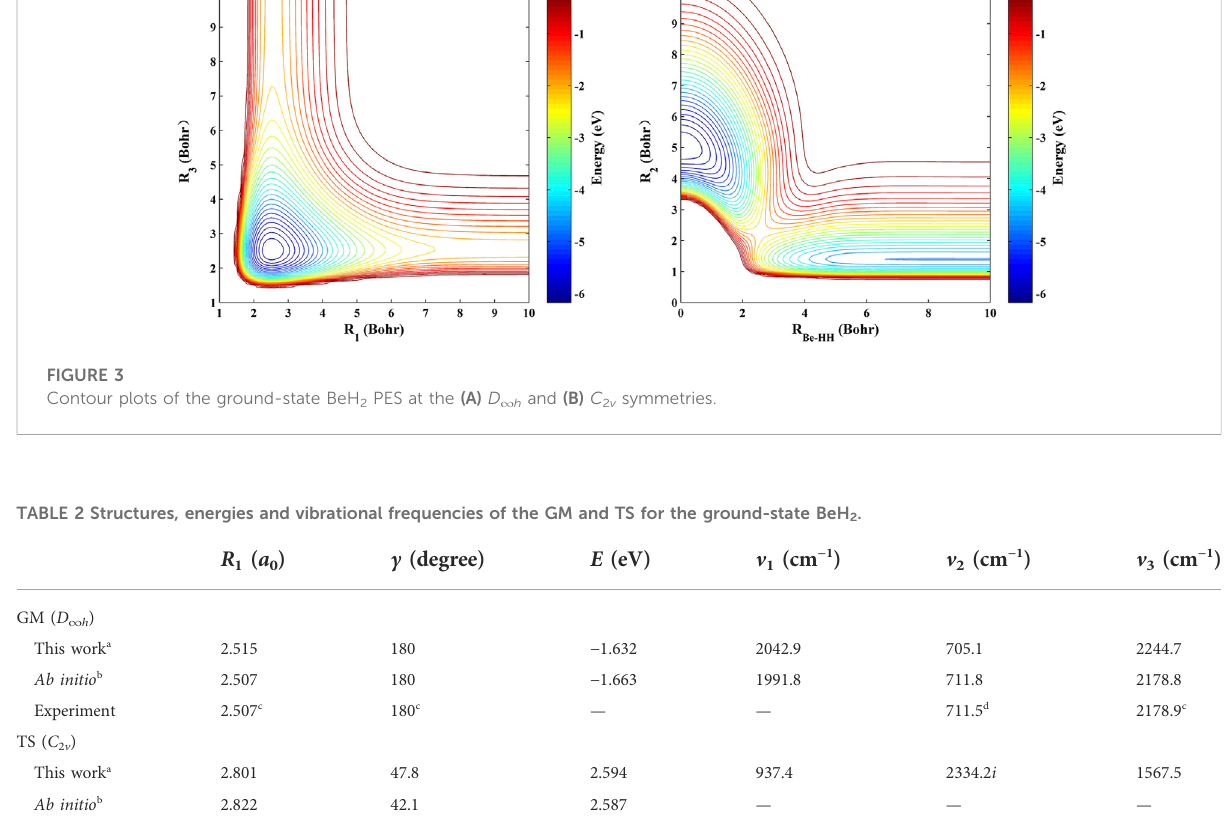
a Obtained on the PIP-NN PES. b Ref. 25. Calculated at the icMRCI/aug-cc-pCV5Z level and the core-electron correlation is included. c Ref. 14. d Ref.